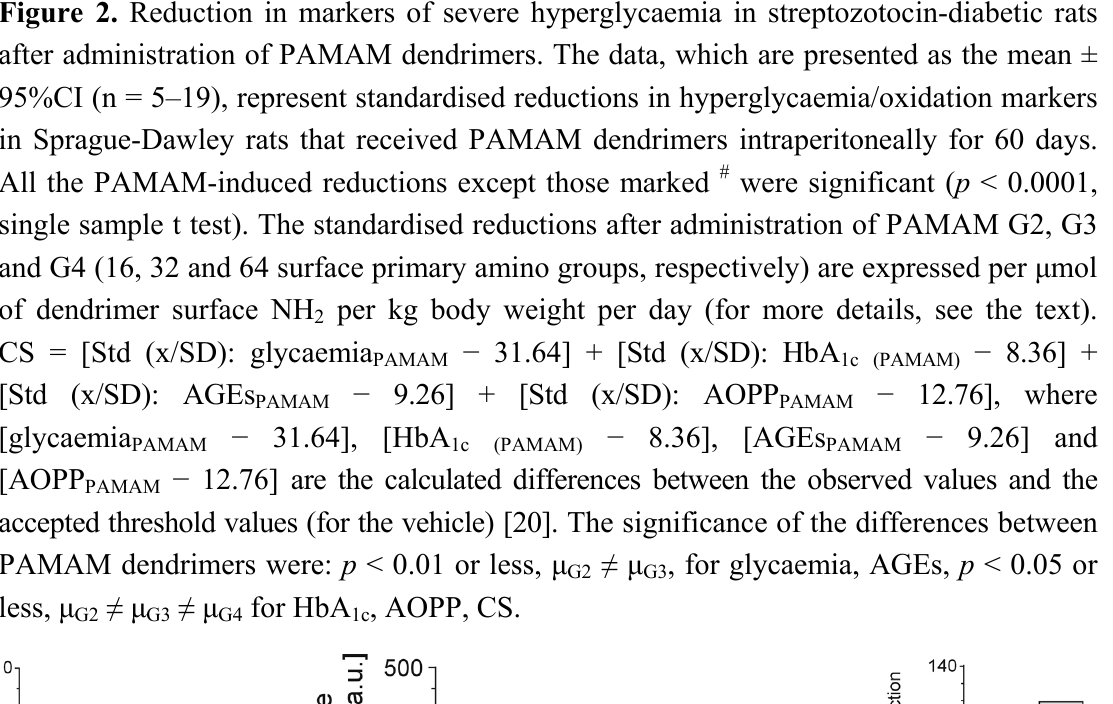
Figure 2. Reduction in markers of severe hyperglycaemia in streptozotocin-diabetic rats after administration of PAMAM dendrimers. The data, which are presented as the mean ± 95%CI (n = 5–19), represent standardised reductions in hyperglycaemia/oxidation